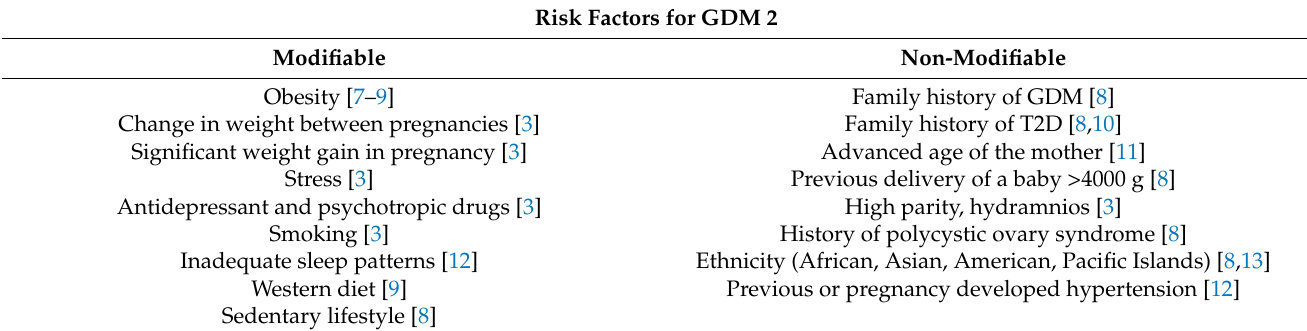
Table 1. The most important modifiable and non-modifiable risk factors that can contribute to the development of GDM. One or more risk factors can be present in the same pregnant woman.